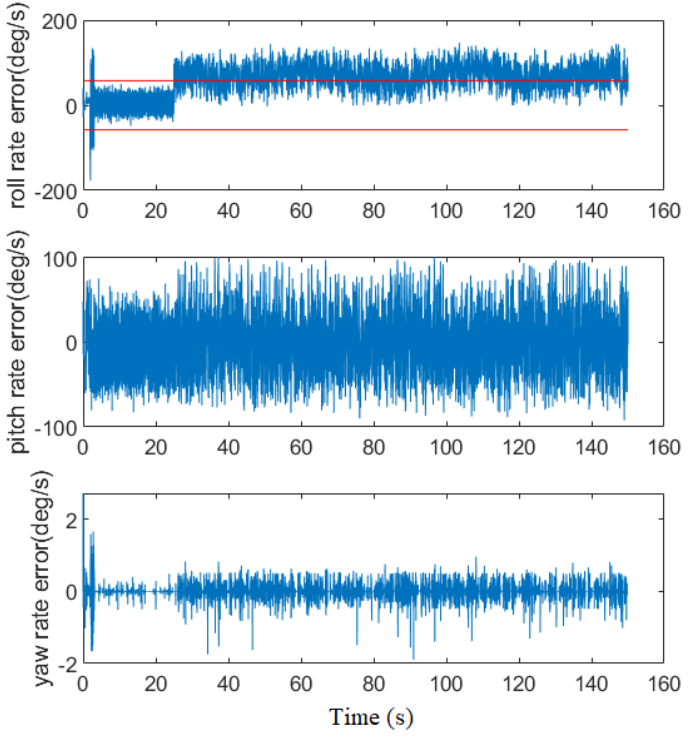
Figure 15. Bias fault: fault diagnosis result (red line–threshold, blue line–residual).